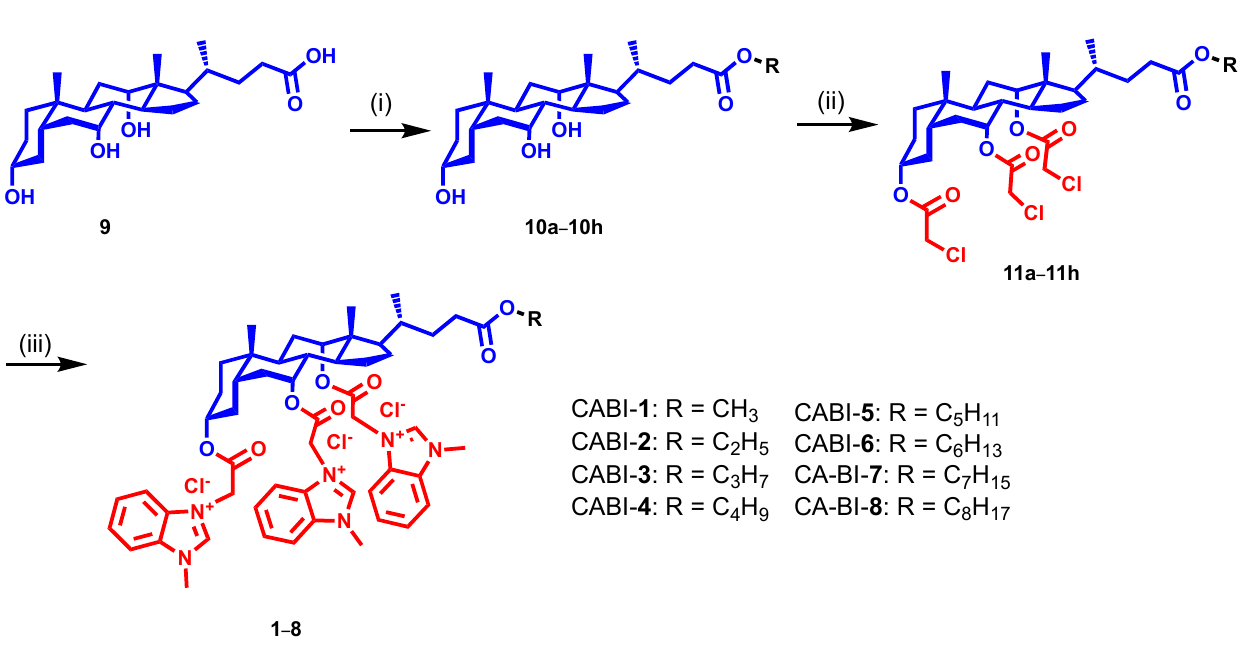
Figure 2. Schema illustrating the synthesis of N -methyl benzimidazole cholic acid amphiphiles.